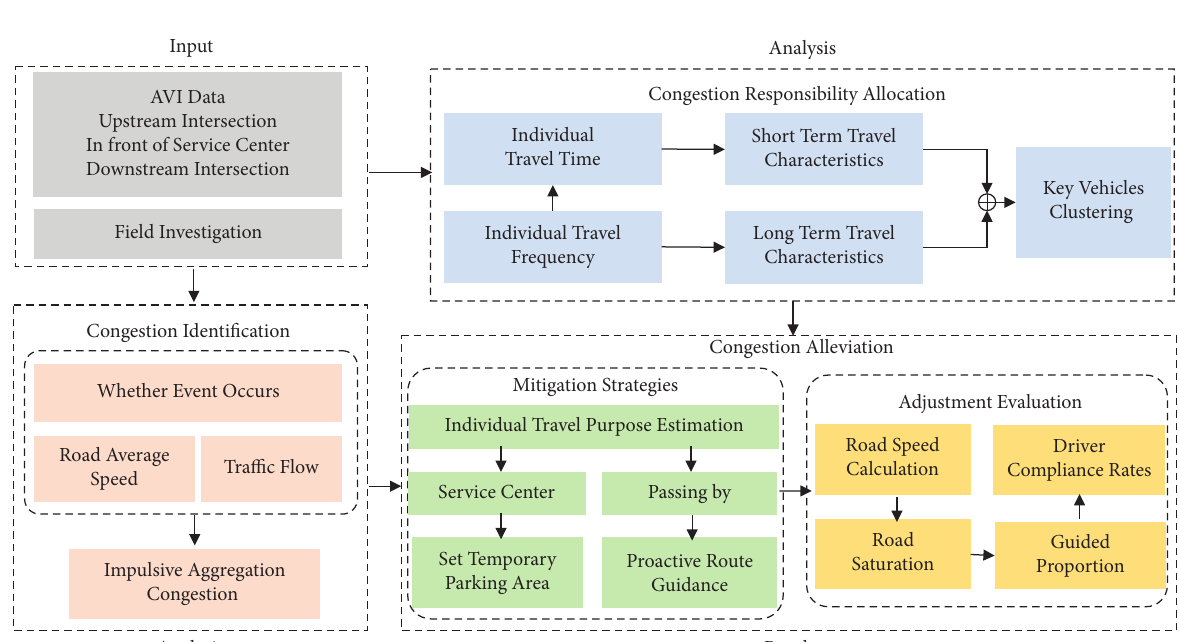
Figure 3: Surroundings of the case school.